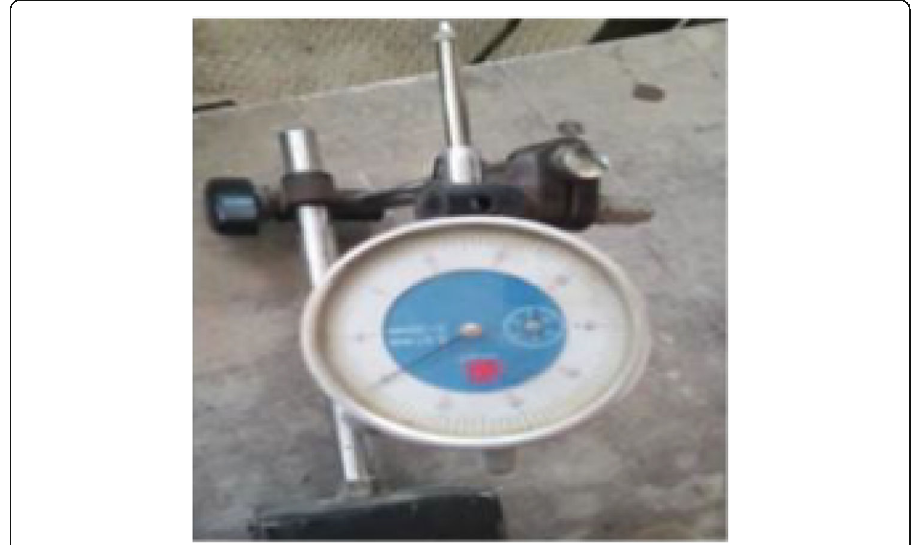
Fig. 3 Dial gage of 0.01 mm